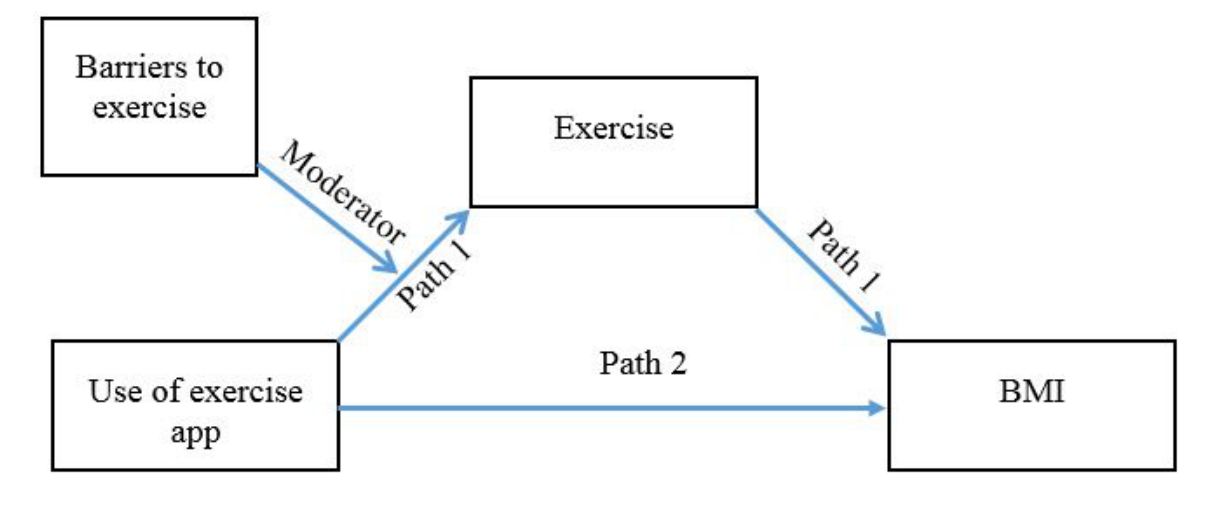
Figure 1. Model of relations between app use, exercise, and BMI, with barriers to exercise as the